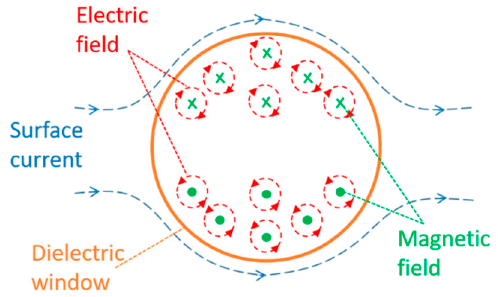
Figure 2. Induced electric field in the dielectric window.